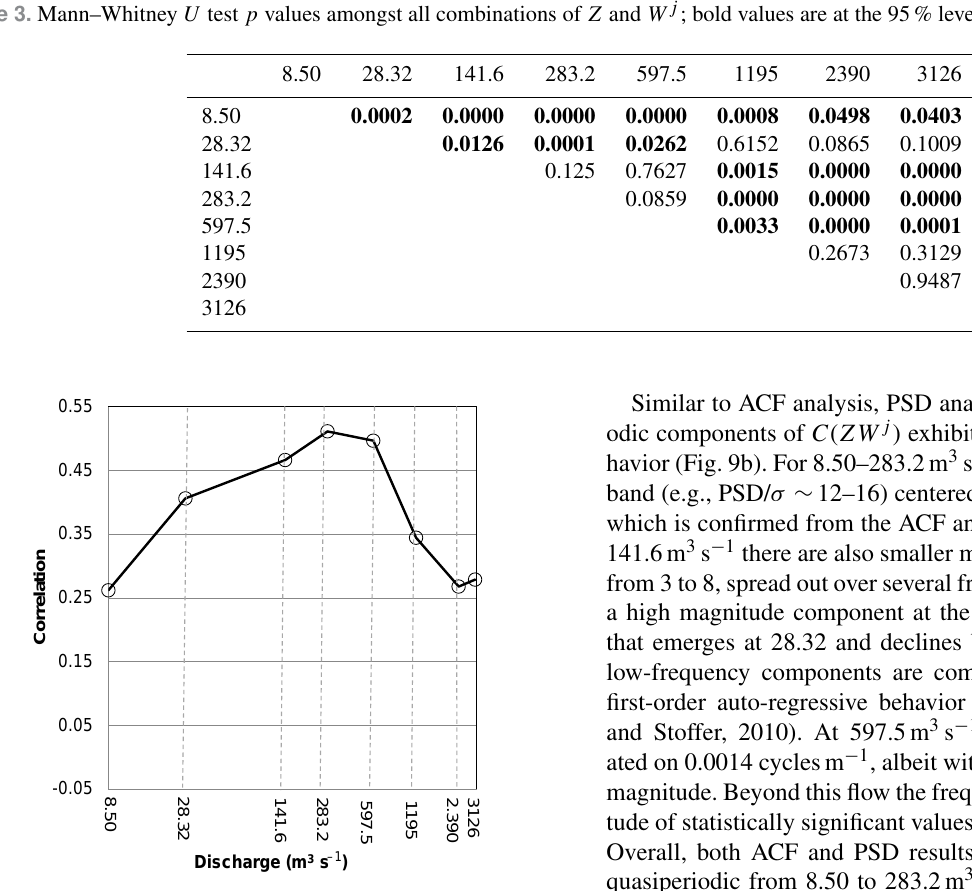
Figure 7. Pearson’s correlation coefficient for Z and W j between each